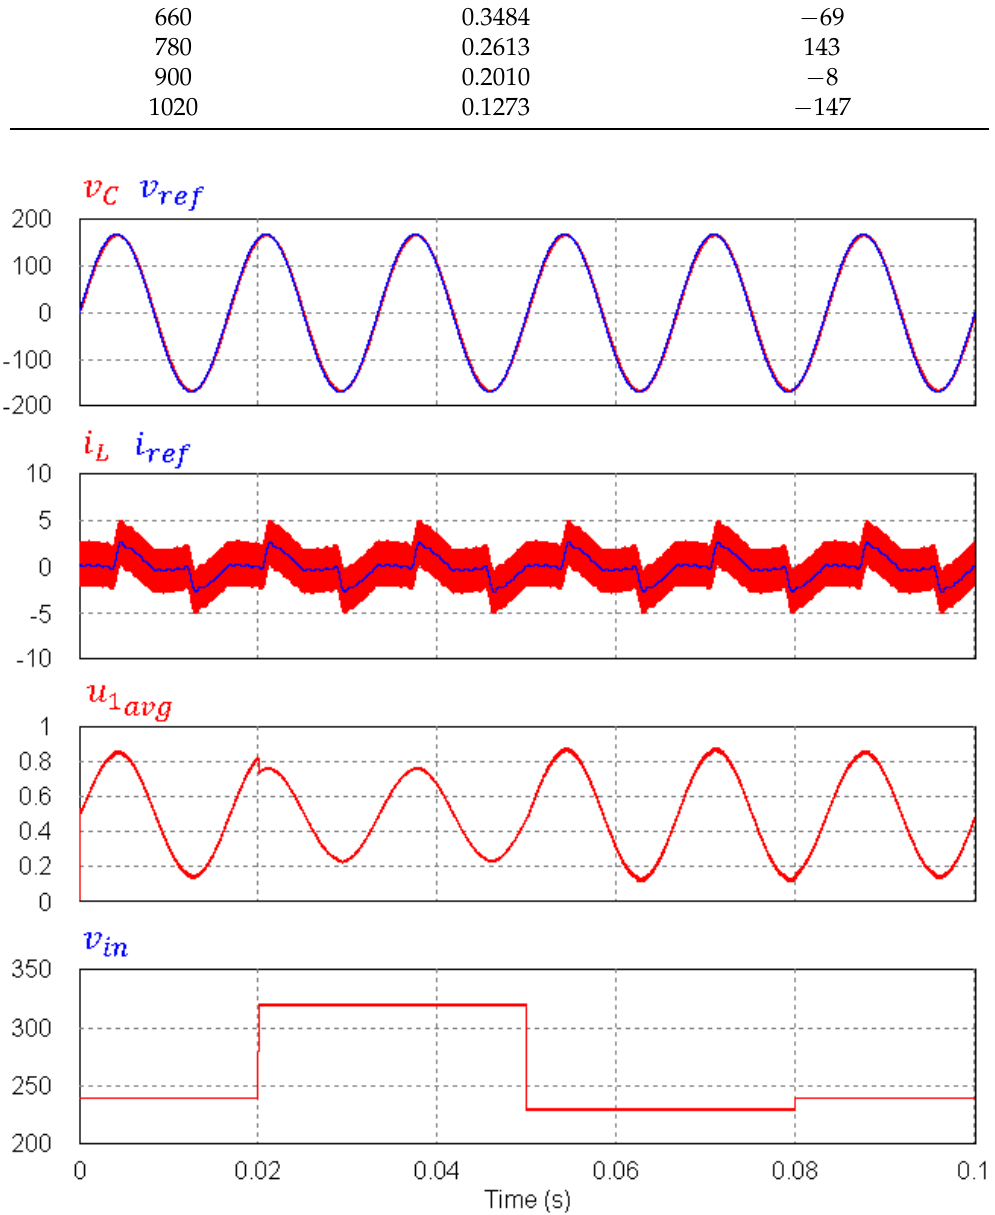
Figure 3. Simulated waveforms of the full-bridge inverter feeding a TBR-type nonlinear load. A second nonlinear load corresponding to a compact fluorescent lamp (CFL) is also considered. The output current in this case has a THD of approximately 99.84% (see the sinusoidal components used in PSIM simulation in Table 3). The output voltage, inductor current, input voltage and the associated duty cycle are shown in Figure 4. The input voltage V in changes as above. For this load, too, the control is efficient and robust, guaranteeing a THD for the output that is lower than